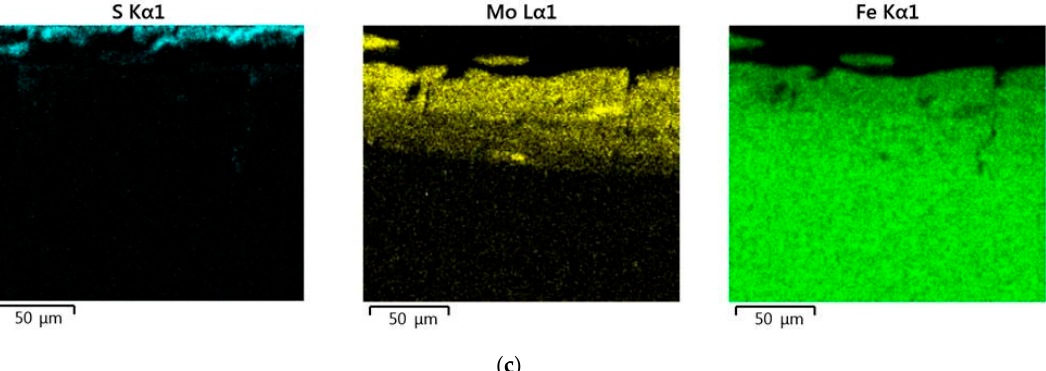
Figure 7. Maps of the distribution of chemical elements in the coating after sulfomolybdenizing steel C40 by ESA method at different discharge energies: ( a ) Wp = 0.13 J; ( b ) Wp = 0.55 J; ( c ) Wp = 3.4 J. As a result of the local energy dispersion X-ray microanalysis, the distribution curves of sulfur, molybdenum, and iron were obtained (see Figure 8). It was observed that sulfur and molybdenum were concentrated at depths of up to 4 and 19 μ m, respectively, at Wp = 0.13 J; up to 5 and 25 μ m, respectively, at Wp = 0.55 J; and up to 15 and 70 μ m, respec- tively, at Wp = 3.4